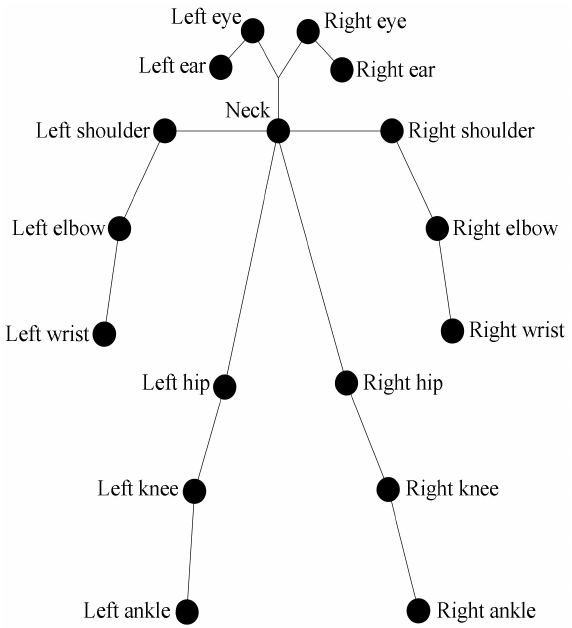
Figure 5. Human skeletal